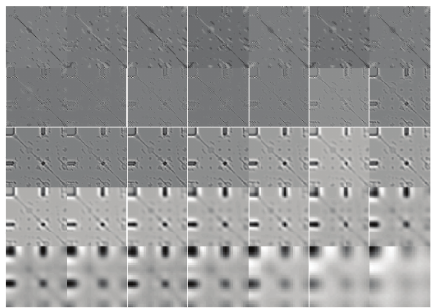
Figure 10: The DOG scale space of the inner race fault under con- dition 1.